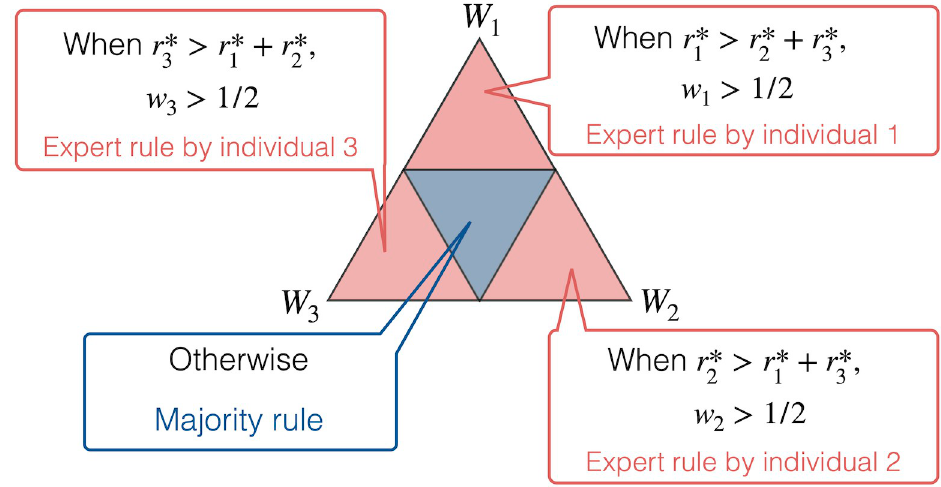
Fig 1. Summary of the region of optimum weights w making involving three individuals. The largest triangle exhibits the 2-simplex { w = ( w 1 , w 2 , w 3 ); w 1 + w 2 + w 3 = 1}, where W 1 , W 2 , and W 3 denote (1,0,0), (0,1,0), and (0,0,1), respectively. Each smaller triangle exhibits the region of optimum weights when each inequality for r � that r